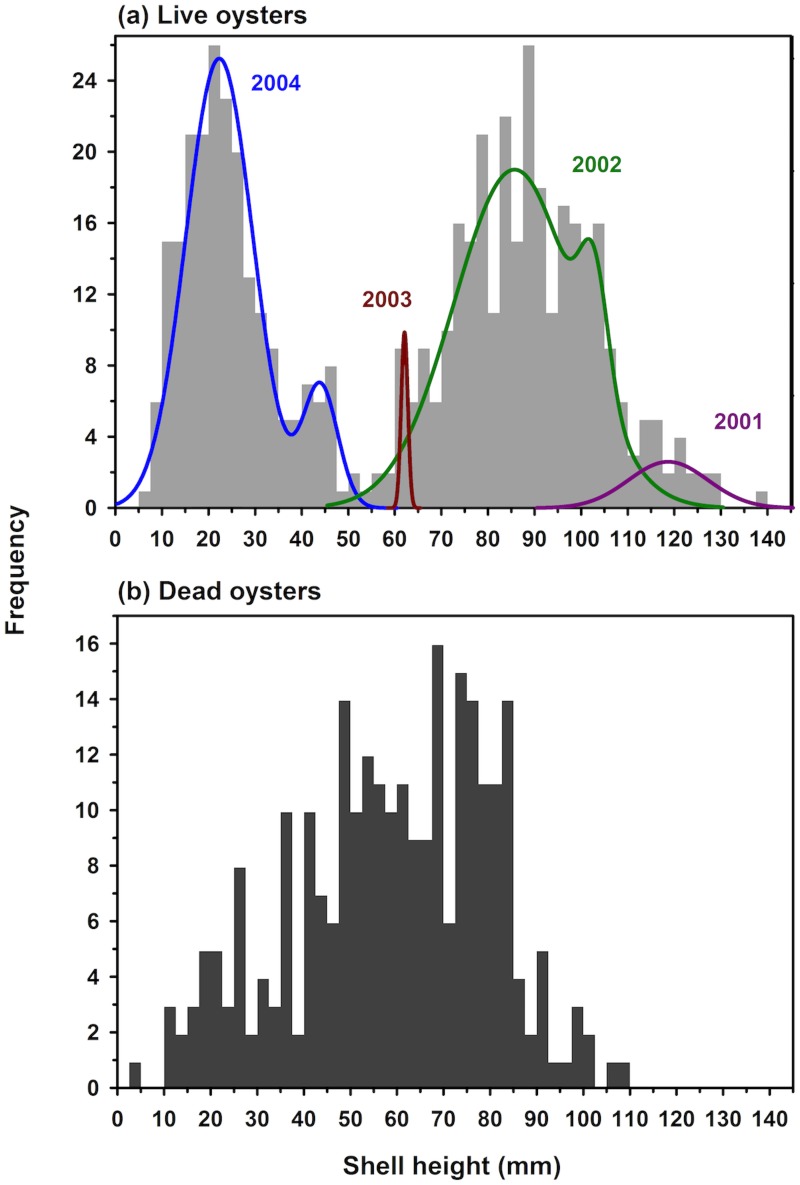
Size frequency of live (a) and dead (b) oysters on the modular reef.The cohorts were distinguished using the R package mixtools. Cohort parameters are in Table 1.